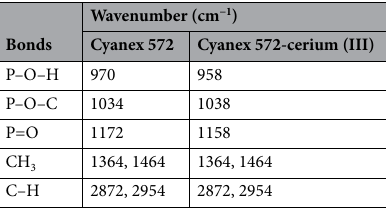
Table 3. IR characteristic peaks for Cyanex 572 and Cyanex 572-cerium (III).